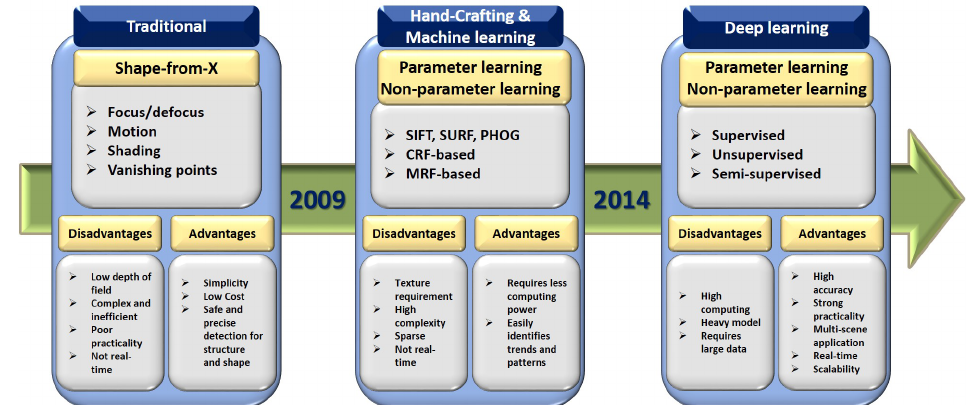
Figure 1. Evaluation trend of DE approaches divided into three sections: traditional methods, hand-crafting and machine learning methods, and deep learning